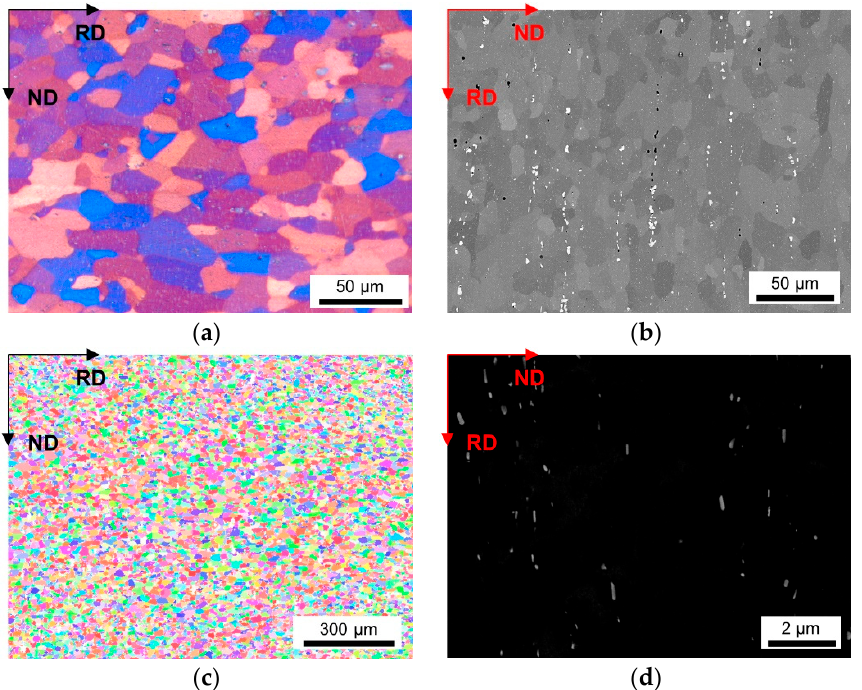
Figure A14. Microstructure of the soft annealed LFe-HMn cast under NR-C conditions, homogenized at 550 °C and cold rolled to a CRD of 35%. ( a ) LOM. ( b ) BSE image. ( c ) EBSD IPF map in RD–ND plane. ( d ) BSE micrograph showing dispersoids.